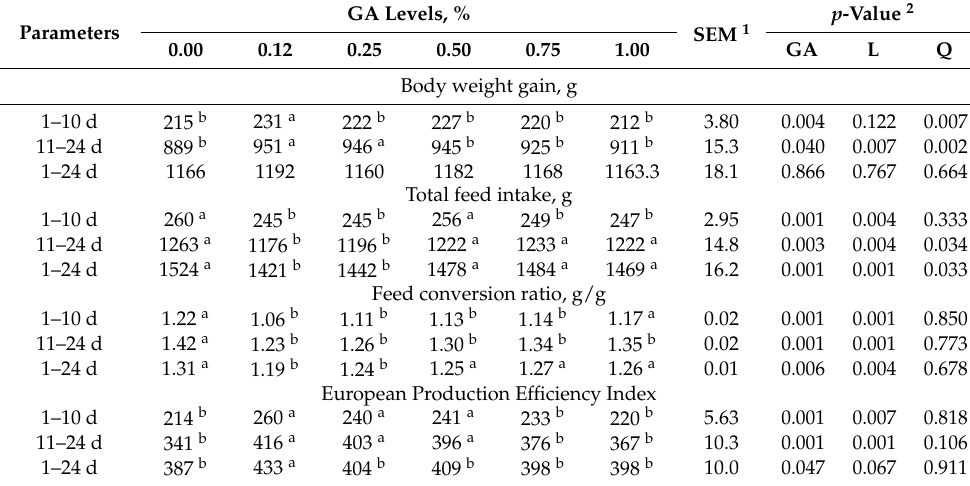
Table 4. Effect of gum Arabic (GA) on general growth performance of male broiler chickens from 1 to 24 days of